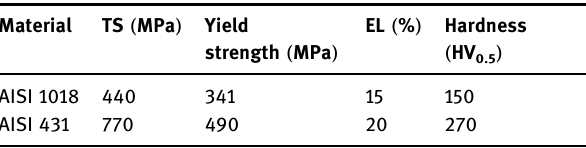
Table 2: Mechanical properties of AISI 1018 steel plate and AISI